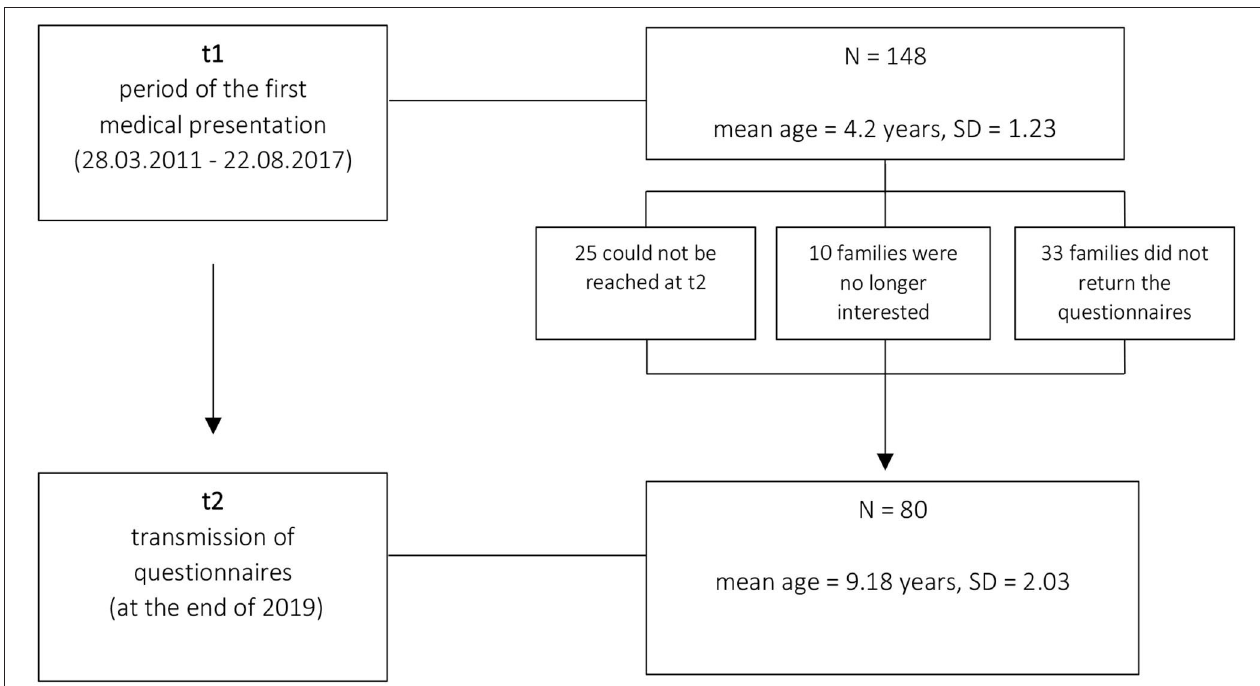
FIGURE 1 | Schematic overview of the methodical